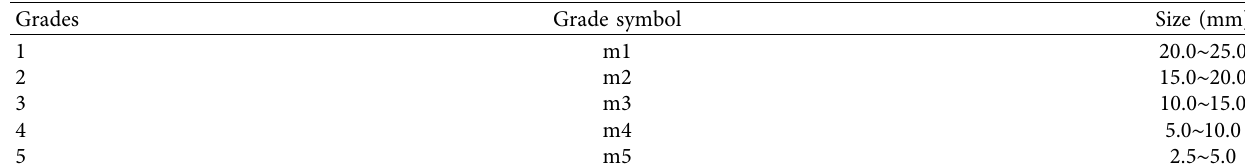
Table 1: Grades and sizes of fragmentized coals.